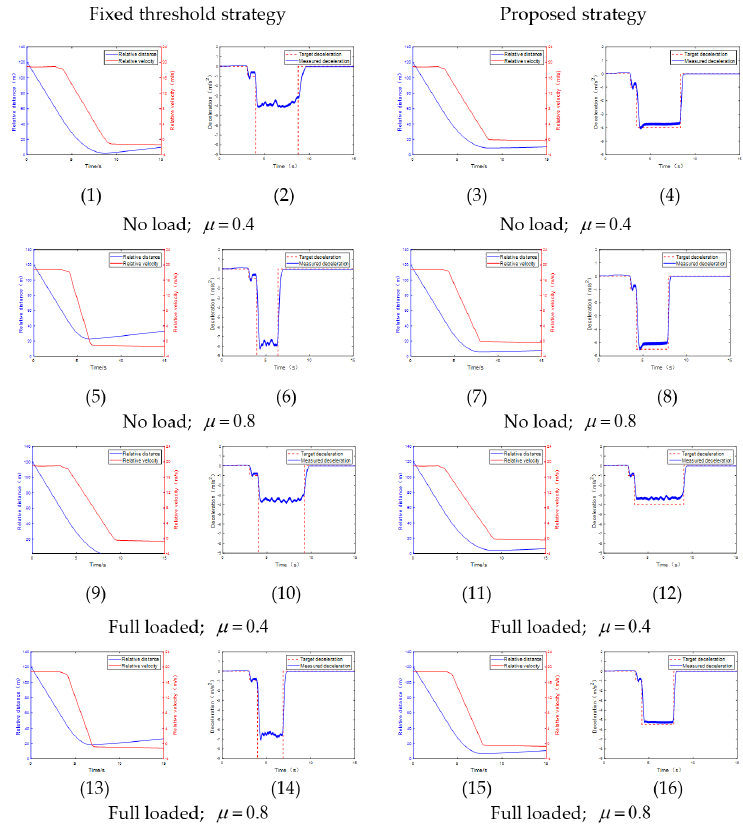
Figure 20. Comparison of the experimental results for the CCRm scenario.